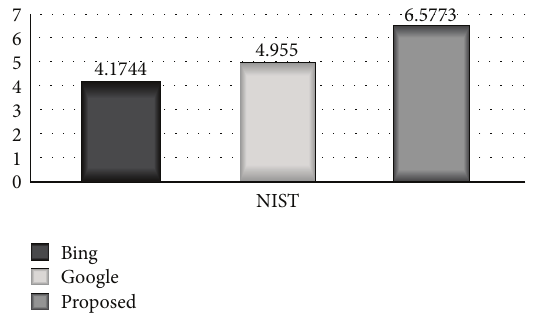
Figure 4: Comparative bar diagram between proposed system, Google, and Bing based on NIST